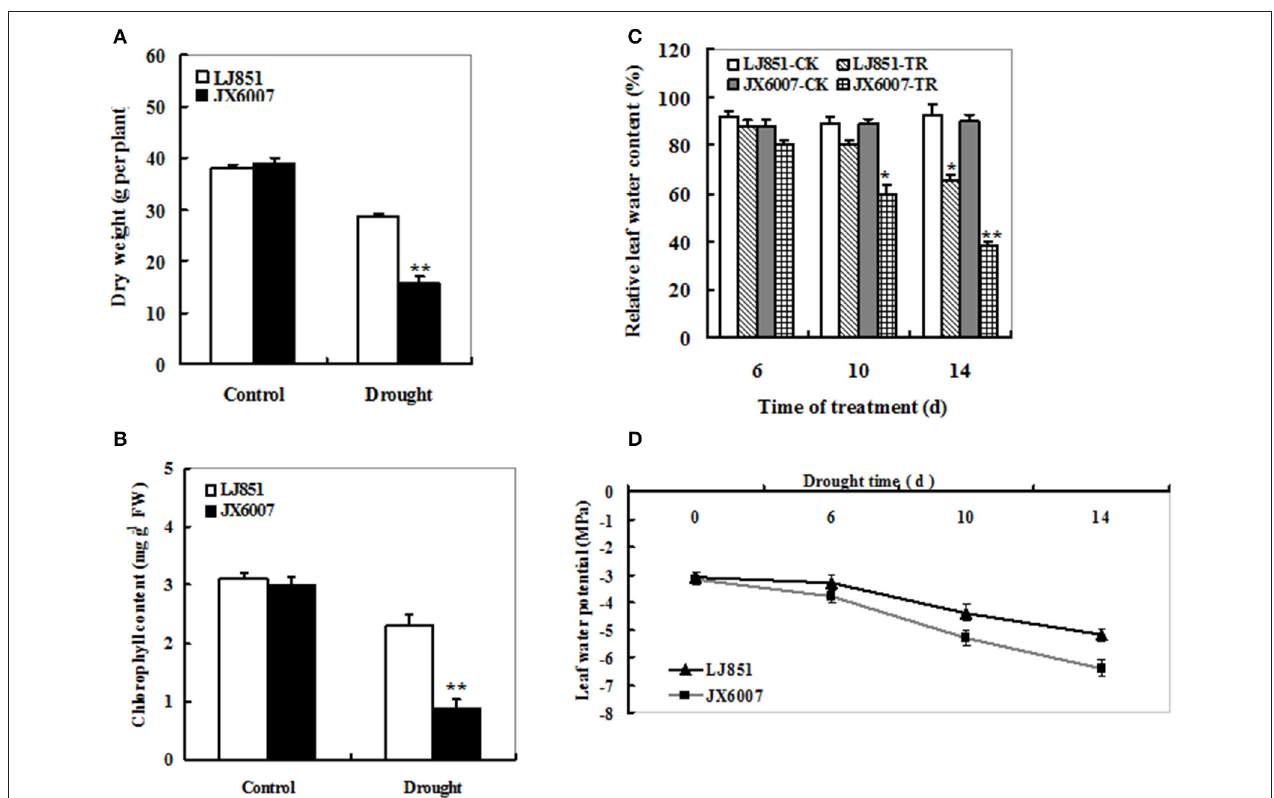
FIGURE 1 | Effects of drought stress on dry weight (A), chlorophyll content (B) , relative leaf water content (C) and leaf water potential (D) in both flue-cured tobacco varieties. LJ851-CK stands for LJ851 under control conditions; LJ851-TR stands for LJ851 under drought conditions; JX6007-CK stands for JX6007 under control conditions; JX6007-TR stands for JX6007 under drought conditions. Bar indicates SE. * t -test, with P < 0.05; ** t -test, with P < 0.01.